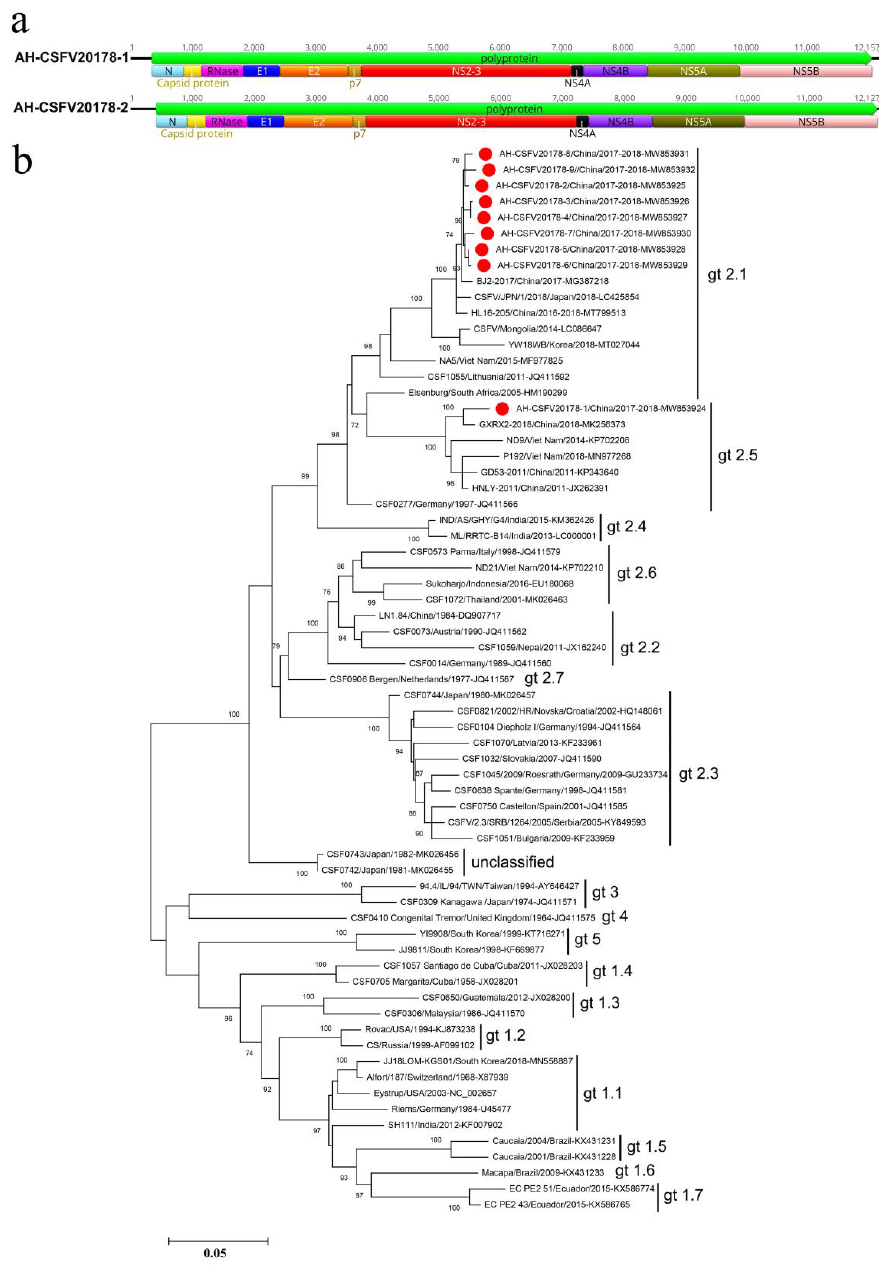
Figure 2. Classical swine fever virus isolated from the sick pigs: ( a ) genomic organization of two different CSFV-representative strains, including the ORFs and viral proteins encoding sequences; ( b ) phylogenetic analysis based on the sequences of E2 of CSFVs identified in this study and the reference strains of other CSFVs. CSFVs identified in this study are marked with solid red circle.